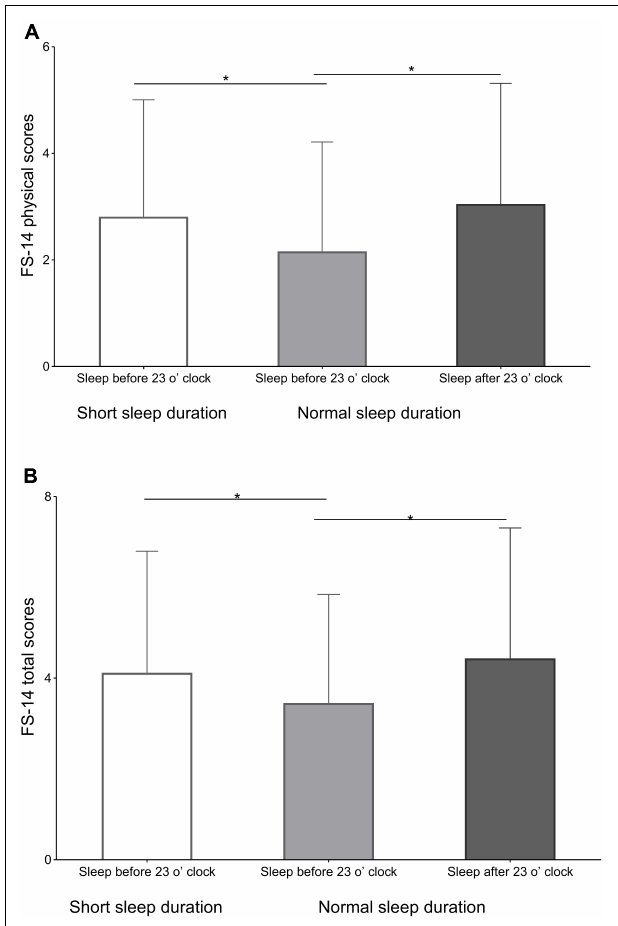
FIGURE 1 | The differences in the 14-item Fatigue Scale (FS-14) physical and total scores. (A) The differences among the FS-14 physical scores of the participants in sleep before 23 o’clock (SBC) of short sleep duration, SBC of normal sleep duration, and sleep after 23 o’clock (SAC) of normal sleep duration. (B) The differences in FS-14 total scores among participants in SBC of short sleep duration, SBC of normal sleep duration, and SAC of normal sleep duration. * p <